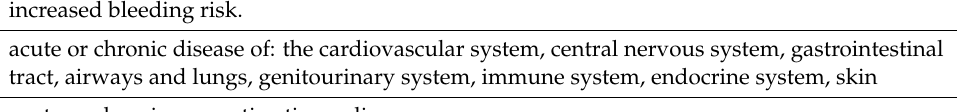
Table 1. Exclusion criteria for the